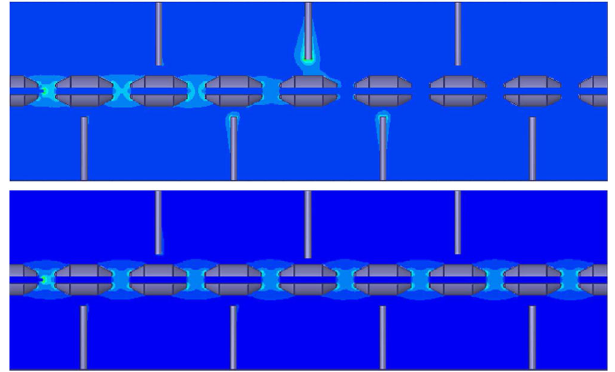
FIG. 4. Axial view of the electric field in an 8 equal-cell DTL perturbed at the left end. Bottom: All post-couplers are set at 187 mm. Top: post-coupler 4 is set to its resonance length l r 4 ¼ 170 mm with the coupling admittance Y 0